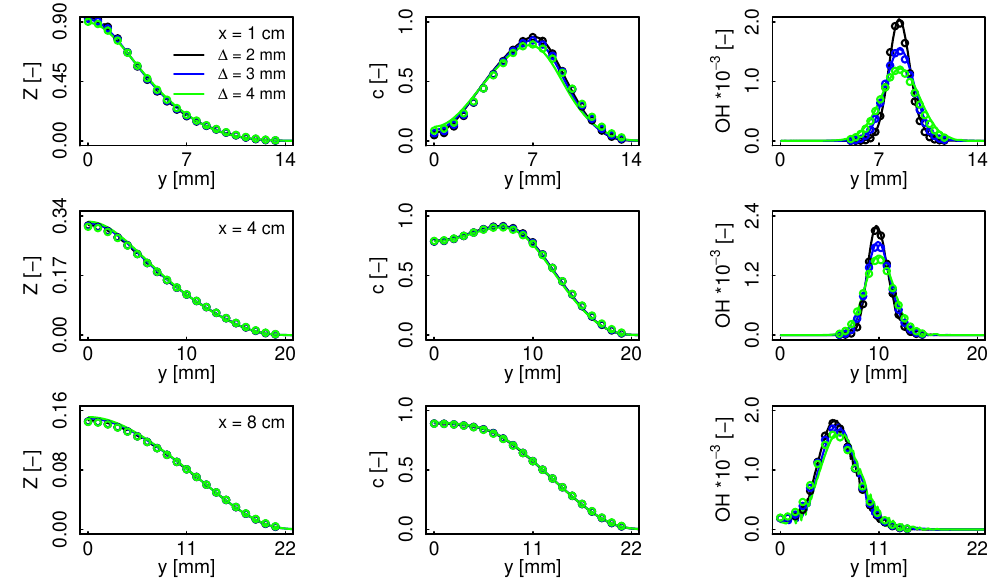
Figure 7. Filtered radial profiles. Solid lines represent the filtered tabulated chemistry results, circles correspond to the filtered reference